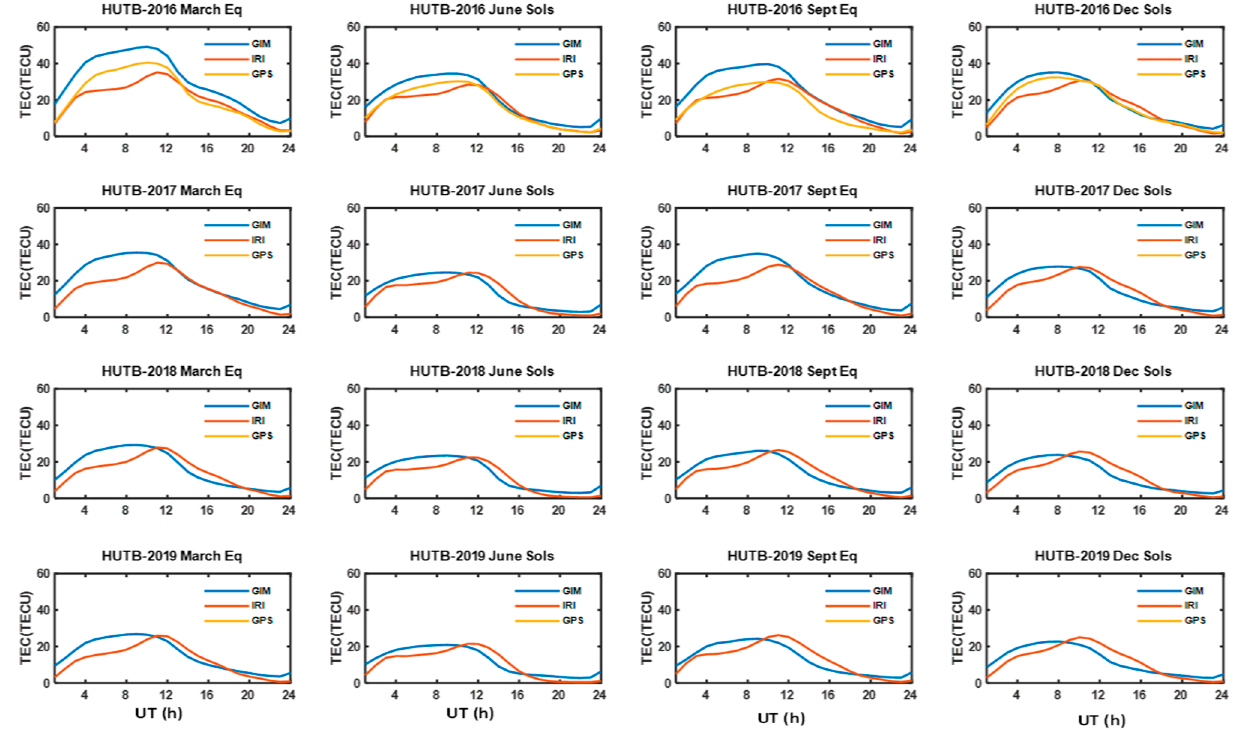
Figure 10. Seasonal variations in GPS-TEC, IRI-2016 and GIM models for descending (2016–2017) and minimum (2018–2019) phases of solar cycle 24 at HUTB.